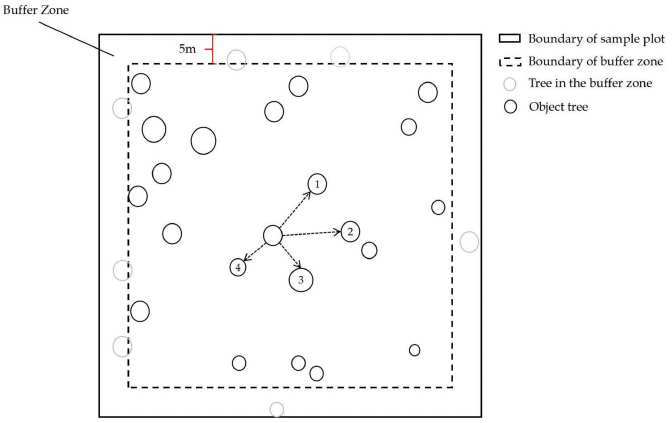
Figure 2. Schematic diagram of the sample plot. Note: Adjacent trees n = 4, Buffer zone = 5